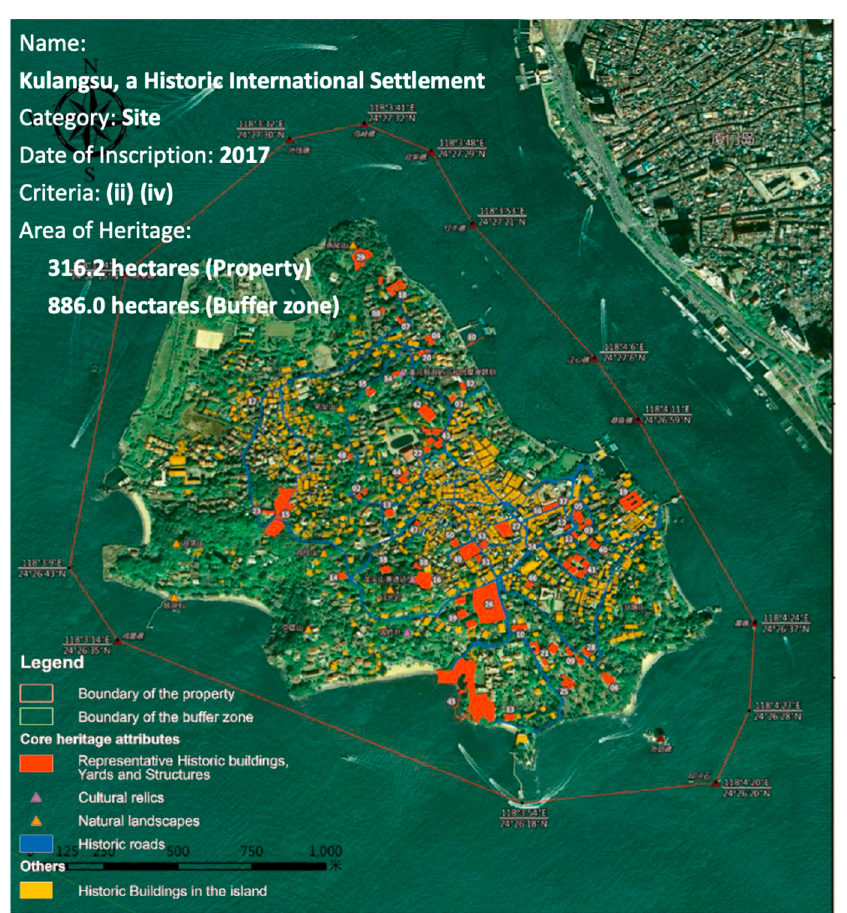
Figure 1. The legend and core heritage attributes of the Kulangsu heritage site. Source: Xiamen Ku-